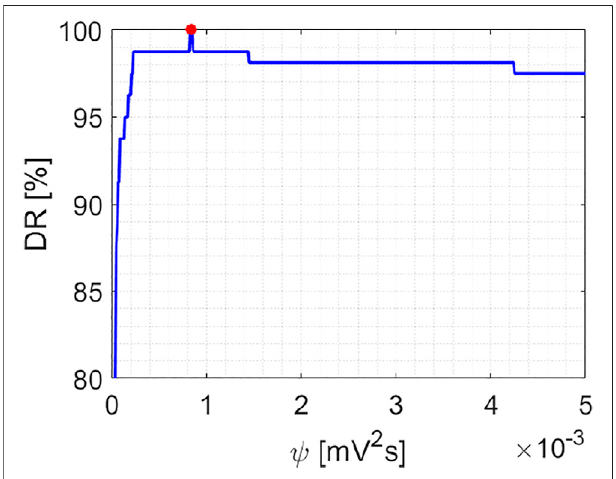
FIGURE 9 | Calibration step. DR versus threshold γ for SDM. The optimal threshold γ p corresponds to the asterisk.